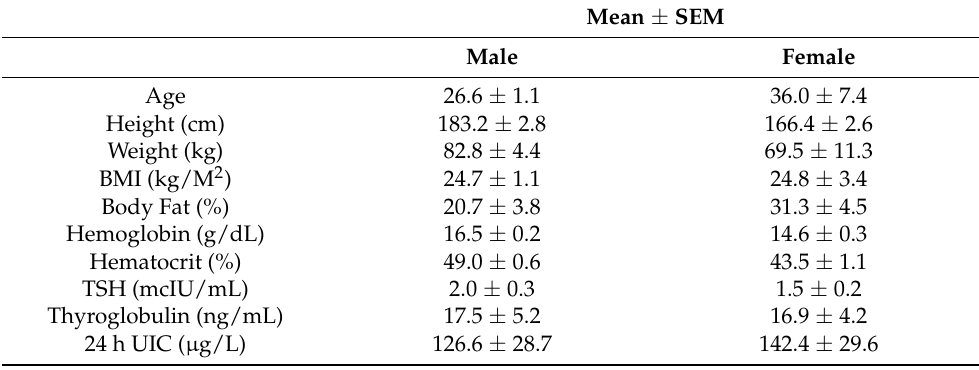
Table 1. Descriptive Characteristics and Baseline Biochemical Values of Participants by Sex.